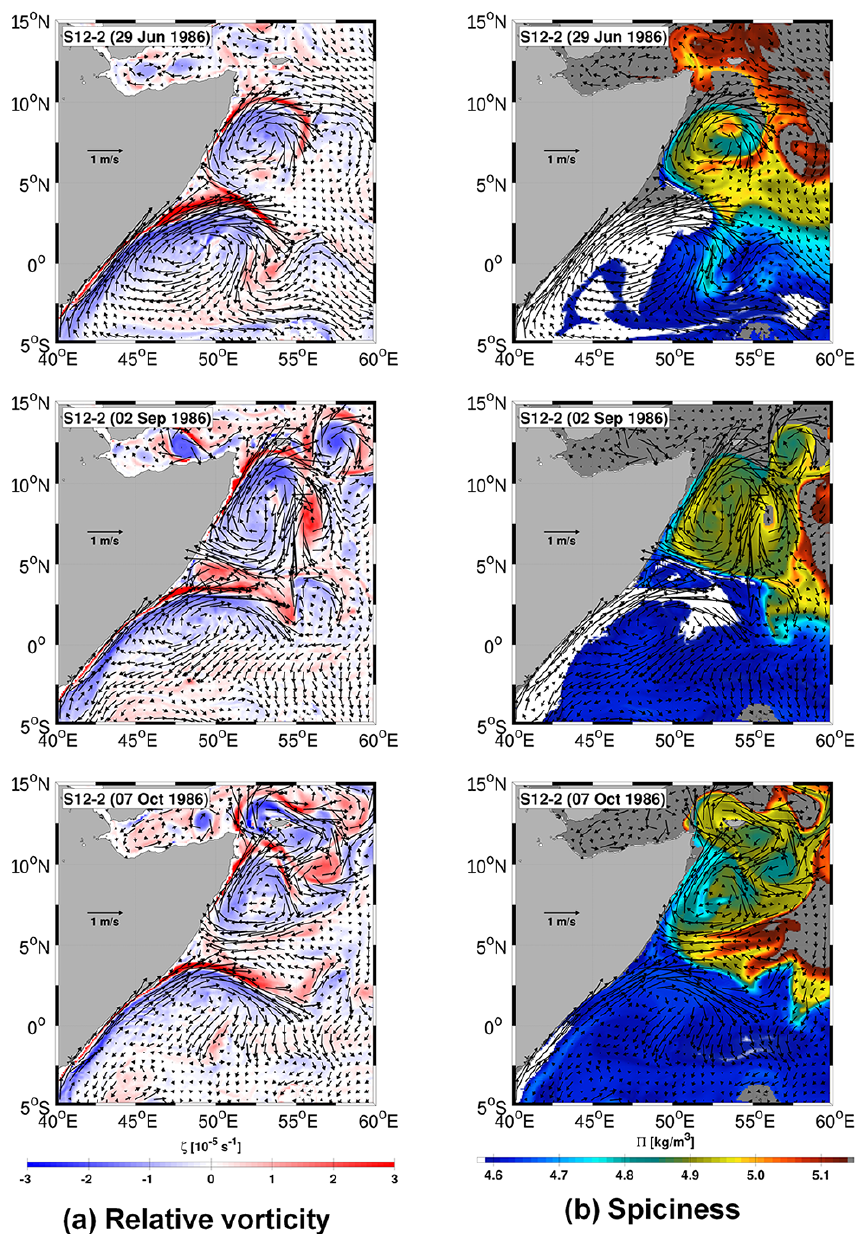
Figure 4. Snapshots of current (vectors; ms − 1 ) at 50m superimposed on (a) relative vorticity ( ζ ; colour shading; s − 1 ) at 50m and (b) spici- ness on isopycnal σ 0 = 23.8 ( (cid:53) ; colour shading; kgm − 3 ), at three different stages of the Southwest Monsoon in 1986 in the 1 / 12 ◦ S12- 2